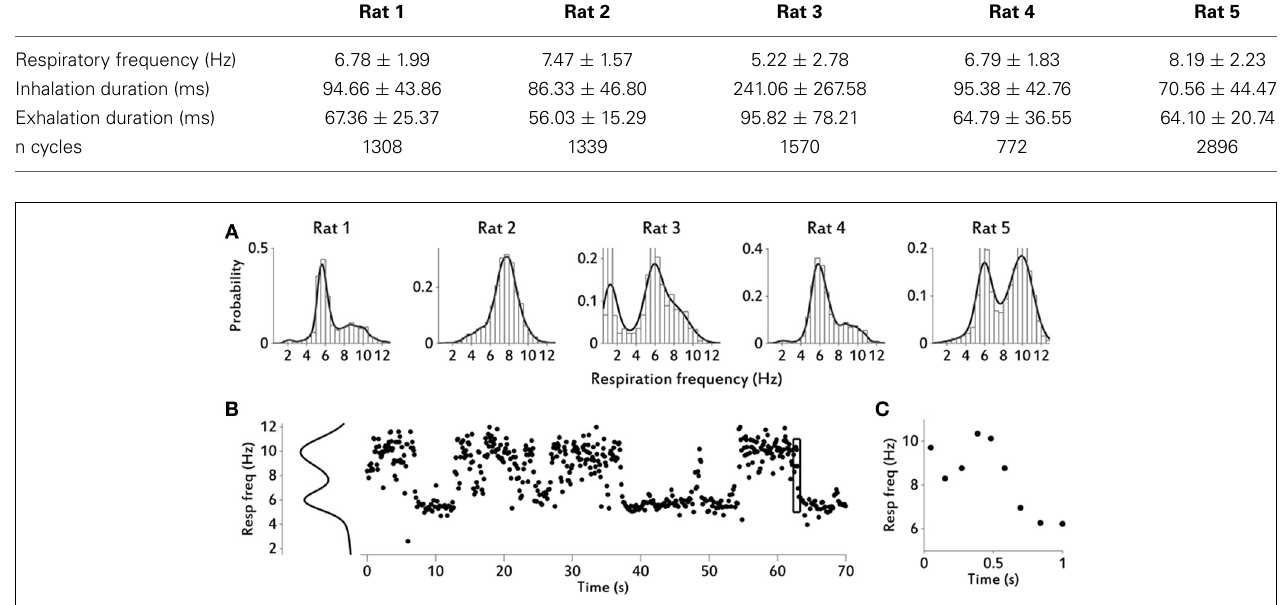
FIGURE 2 | Respiratory frequency distributions and variability over time. (A) Respiratory frequency distributions for all rats. Numbers of respiratory cycles per rat are shown in Table 1 . Rats 3 and 5 showed behavioral periods of quietness, almost to the point of falling asleep, especially Rat 3. In these periods, respiratory frequency decreased considerably. (B) Example of